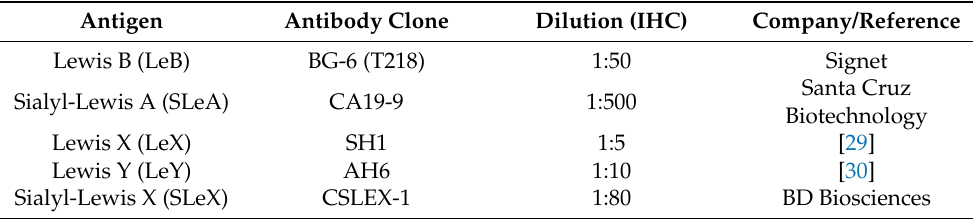
Table 1. Monoclonal antibodies used for Lewis antigens analysis by immunohistochemistry.